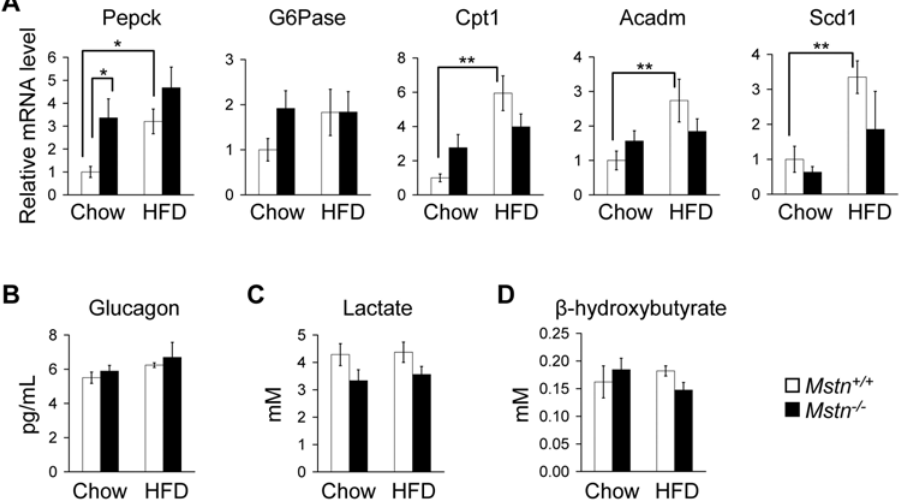
Figure 6. Adaptation to increased muscle mass. ( A ) Relative mRNA expression levels in liver of Pepck , G6Pase , Cpt1 , Acadm , and Scd1 measured by quantitative RT-PCR in Mstn + / + and Mstn 2 / 2 mice on standard chow or HFD. ( B ) Serum glucagon, ( C ) lactate, and ( D ) b -hydroxybutyrate levels in Mstn + / + and Mstn 2 / 2 mice on standard chow and HFD. n =6–12. * P , 0.05, ** P , 0.01.